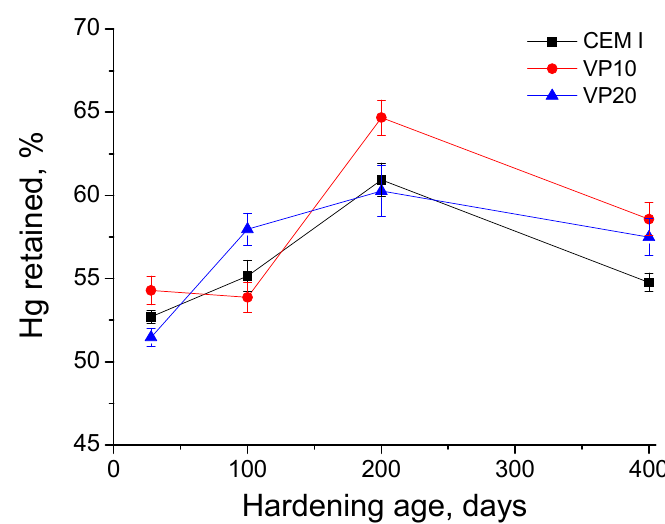
Figure 8. Percentage of mercury retained at the end of mercury intrusion porosimetry test for the mortars analyzed.